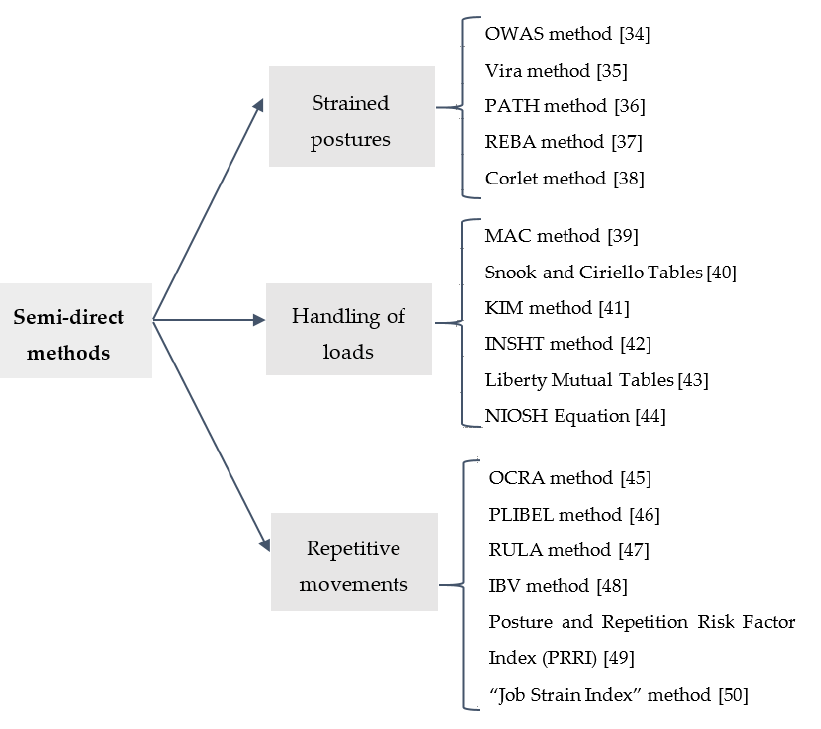
Figure 3. Semi-direct methods (adapted from [33]).